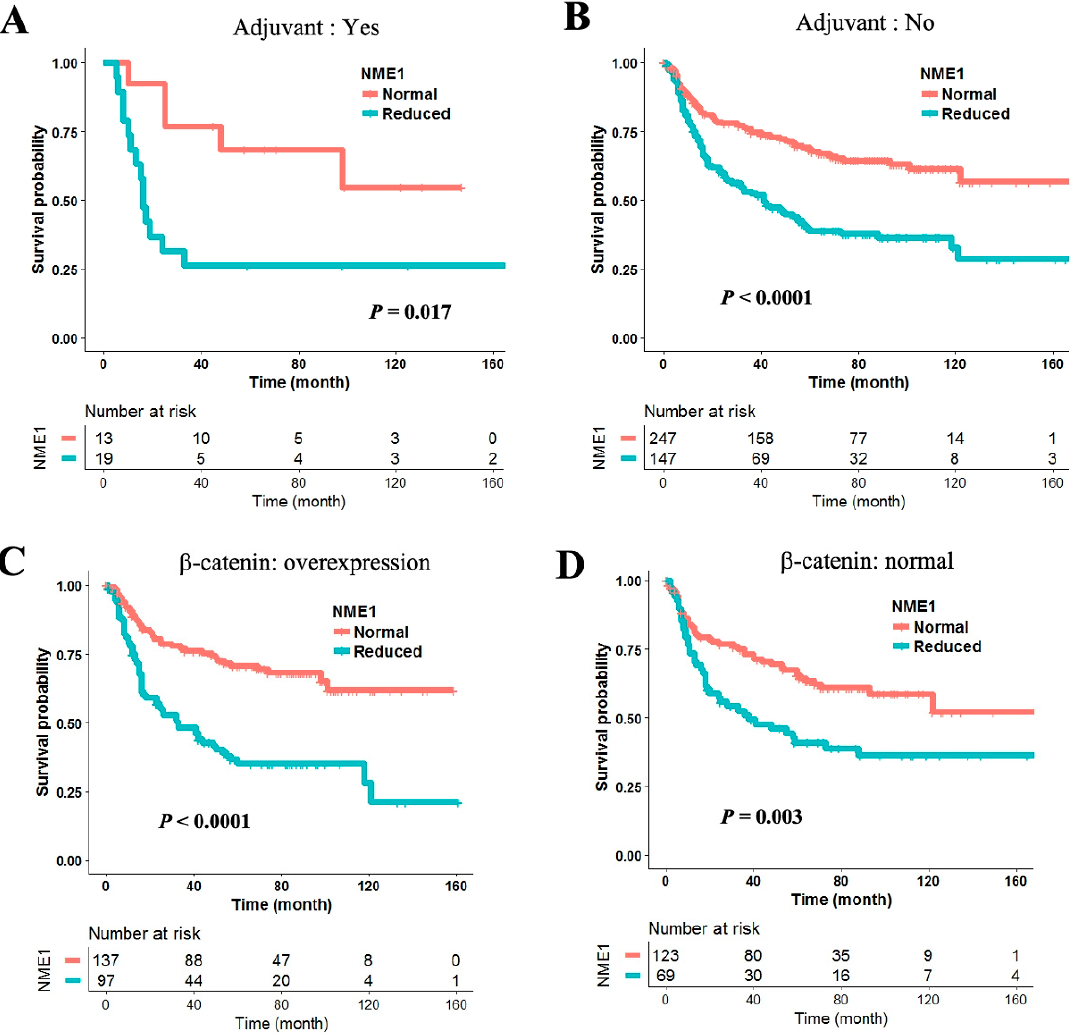
Figure 3. Effect of NME1 on recurrence-free survival, stratified by β -catenin expression and cisplatin-based adjuvant chemotherapy. To understand whether the effect of NME1 on RFS was confounded by β -catenin expression or cisplatin-based adjuvant chemotherapy, data were stratified by β -catenin overexpression ( A , B ) or cisplatin-based adjuvant chemotherapy ( C , D ) and then the survival curves were compared according to NME1. The survival was compared using the log-rank test in 425 non-small cell lung cancers